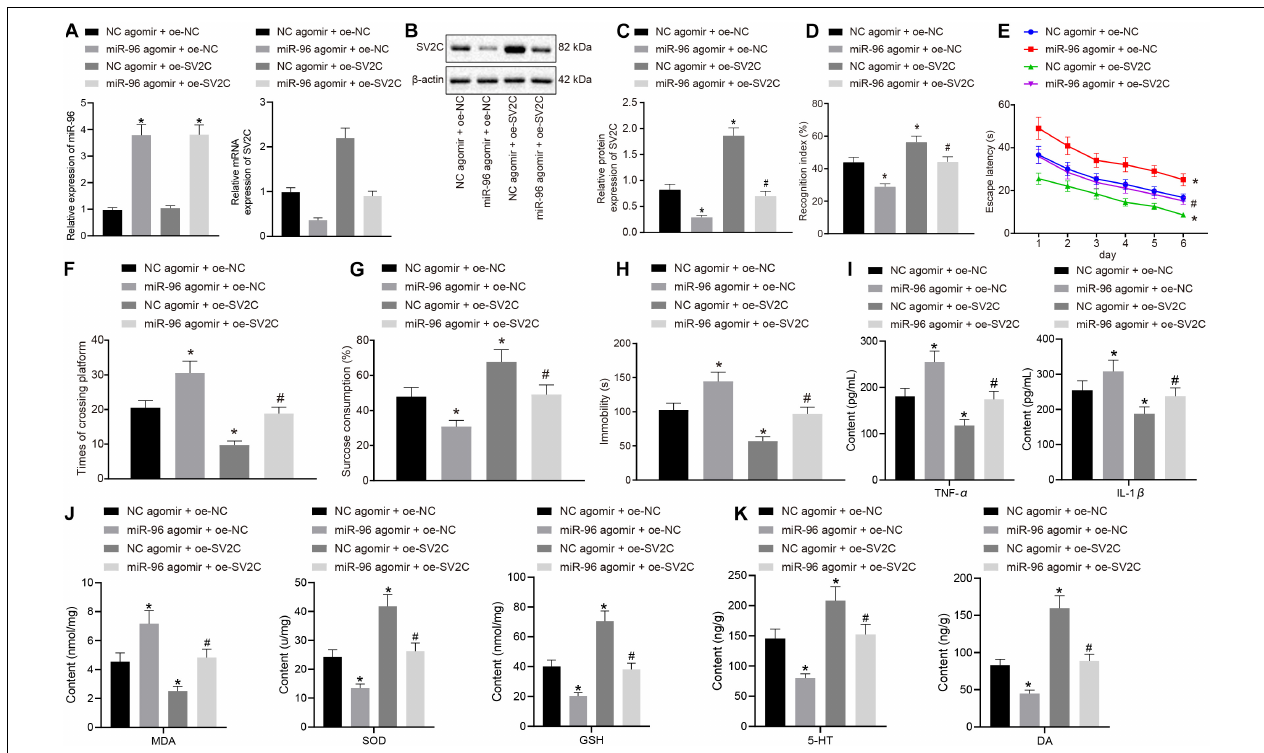
FIGURE 4 | miR-96-targeted SV2C overexpression relieved depression-like behavior and memory impairment in mice. LPS-treated model-operated mice were injected with NC agomir + oe-NC, miR-96 agomir + oe-NC, NC agomir + oe-SV2C, or miR-96 agomir + oe-SV2C. (A) RT-qPCR detection of miR-96 expression and SV2C mRNA expression in brain CA1 region of mice [ N = 10, F MiR − 96 (3,36) = 333.8, F SV2C (3,36) = 321.3]. (B,C) Western blot analysis of SV2C protein expression in brain CA1 region of mice [ N = 10, F (3,36) = 420]. (D) NORT index of mice [ N = 10, F (3,36) = 144.2]. (E) Escape latency time of mice in Morris water maze experiment [ N = 10, F (15,216) = 1.899]. (F) Frequency of crossing platform in Morris water maze experiment [ N = 10, F (3,36) = 135.7]. (G) Sucrose preference index of mice [ N = 10, F (3,36) = 74.91]. (H) Swimming immobility time of mice by forced swimming experiment [ N = 10, F (3,36) = 122.9]. (I) Levels of inflammatory factors TNF- α and IL-1 β in CA1 region of brain in mice detected by ELISA [ N = 10, F TNF − α (3,36) = 96.16, F IL − 1 β (3,36) = 37.39]. (J) Levels of MDA, SOD, and GSH in CA1 region of brain in mice [ N = 10, F MDA (3,36) = 88.85, F SOD (3,36) = 165.2, F GSH (3,36) = 200.7]. (K) Level of 5-HY and DA in brain CA1 region of mice [ N = 10, F 5 − HY (3,36) = 88.85, F DA (3,36) = 206.1]. * p < 0.05 vs. LPS-treated mice injected with NC agomir + oe-NC, # p < 0.05 vs. LPS-treated mice injected with miR-96 agomir + oe-NC. Measurement data were expressed as mean ± standard deviation. Comparisons among multiple groups were conducted by ANOVA, followed